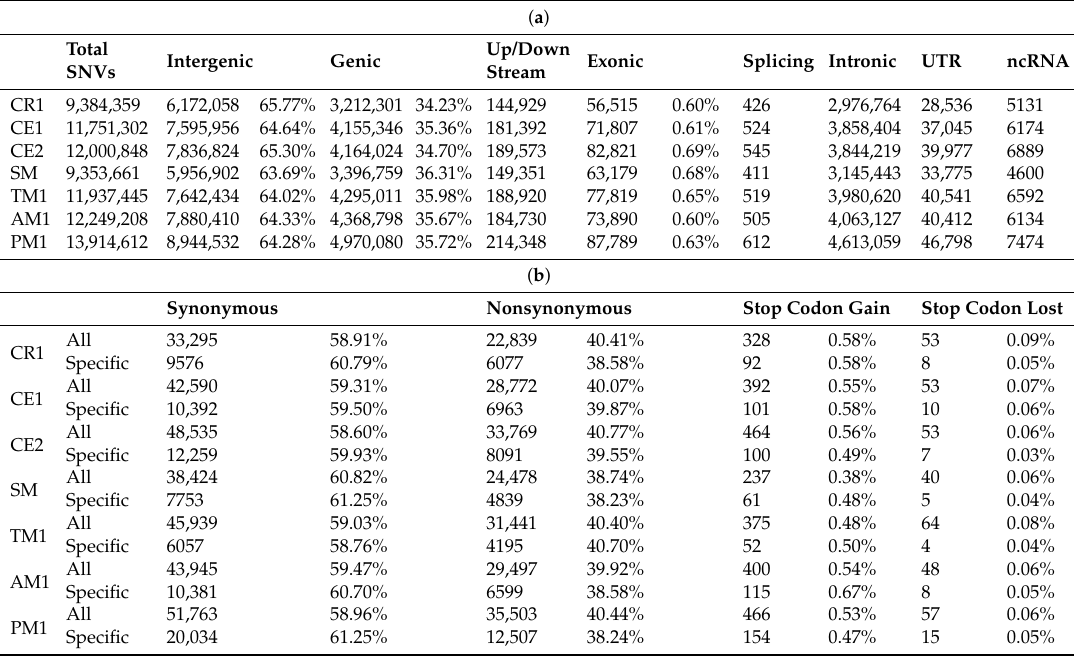
Table 3. Functional annotation of ( a ) all processed SNVs and ( b ) exonic SNVs in Macaca species based on rheMac2 provided by